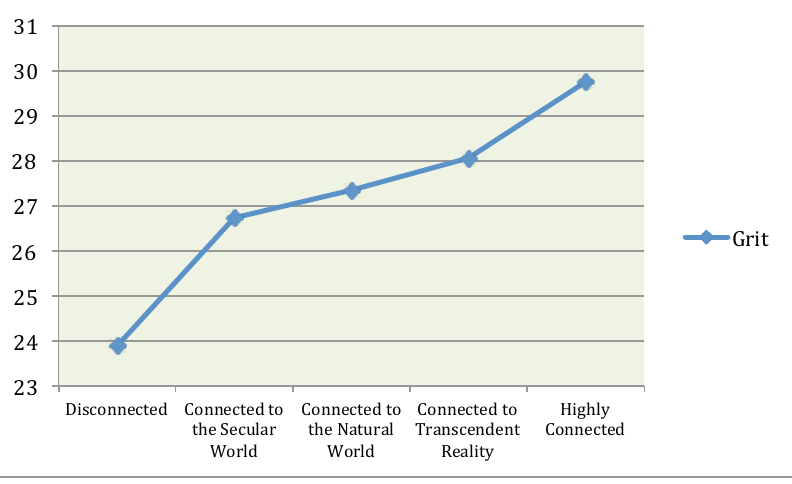
Figure 6. One-way ANOVA of mean grit across five classes of spiritual connection, F=13.65*. * p <